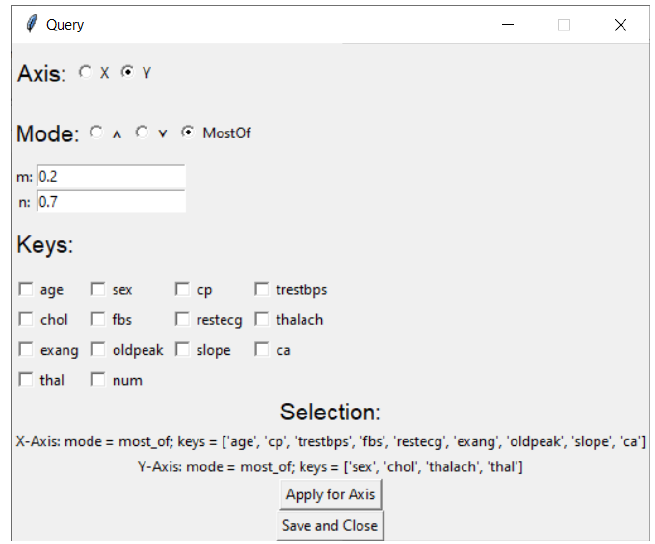
Figure 14. The query window allows the user to define the quantifier function for each axis. The axis ( “Axis” ), quantifier mode ( “Mode” ) and the attributes ( “Keys” ) can be selected here. The bottom section shows the current selection.